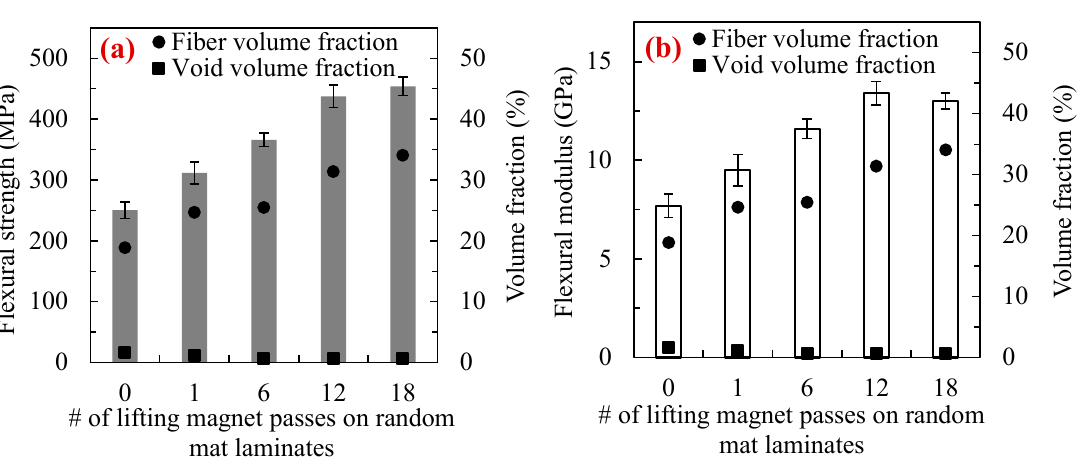
Figure 8. Scanning electron microscopy (SEM) images of plain weave laminates (at 150× magnification) made by WLVB process and sliding lifting magnet on the saturated lay-up with ( a ) 0 pass; ( b ) 6 passes; and ( c ) 12 passes. Note: Arrows point to the small voids inside the fiber tows.